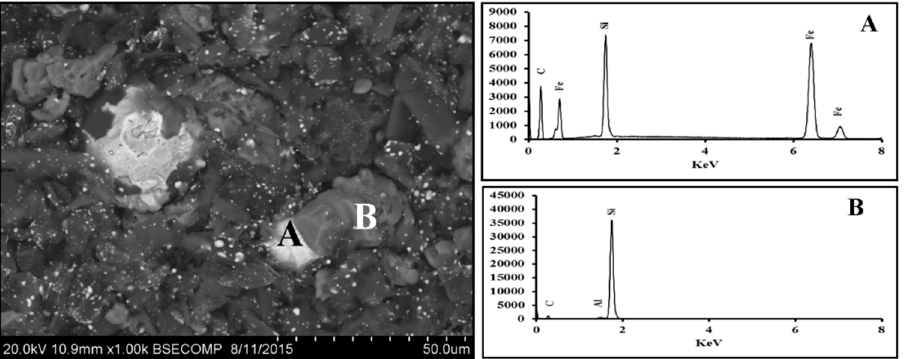
Figure 6. The HRSEM/EDS images for the reacted assembly after heat treatment for 15 min at 1550 °C, indicating a complex mixture of phases.